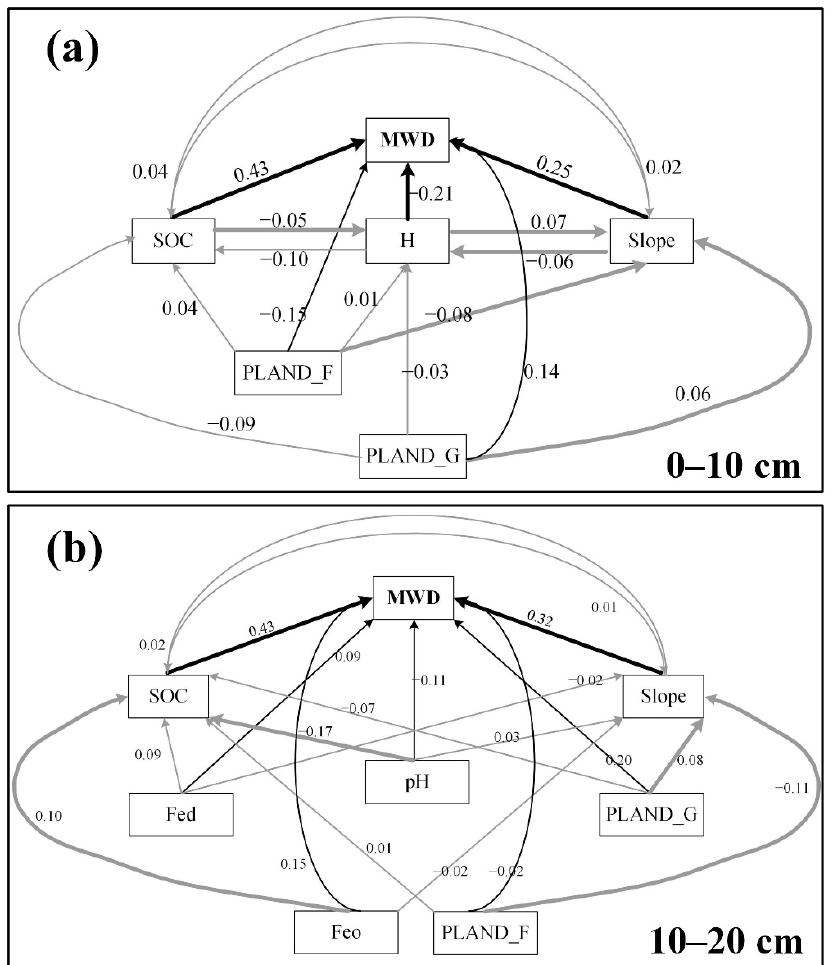
Figure 4. Path analysis results on the direct and indirect effects of soil, nature, and land use on MWD at 0–10 cm ( a ) and 10–20 cm ( b ) in Zhifanggou watershed. Numbers show the path coefficients. Black and grey paths indicate direct and indirect effects, respectively. Thick lines indicate significant relationships ( p < 0.05) and the fine lines indicate non-significant relationships. SOC, soil organic carbon; Fe d : free iron; Fe o , amorphous iron; H: elevation; PLAND_F and PLAND_G: the proportion of the landscape occupied by farmland and grassland, respectively. MWD: mean weight